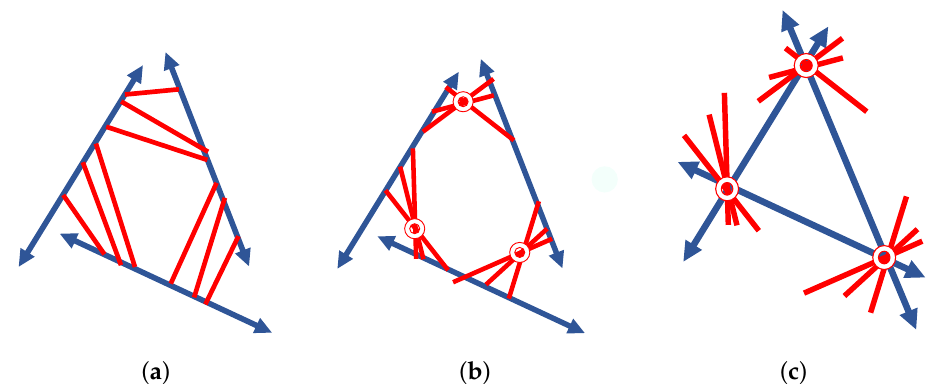
Figure 55. Three rods in P 3 are generically rigid with three triples of connecting bars ( a ), and still infinitesimally rigid with the triples each concurrent ( b ), even with the rods crossing effectively as clamps ( c